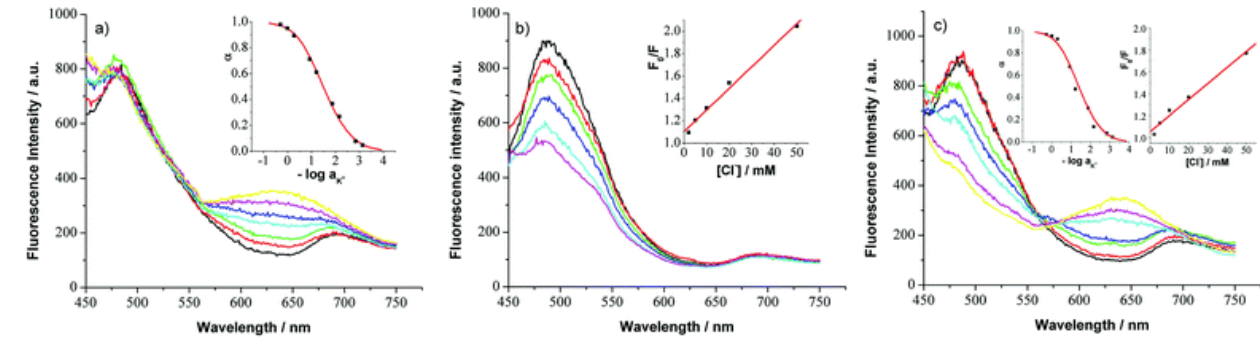
Figure 4. Emission spectra of acrylic/QDs nanospheres acting as: (a) single K + sensors after addition of KHCO solutions. (b) Single Cl - sensors after addition of NaCl solutions. (c) K + /Cl 3 sensors after addition of KCl solutions. Concentrations: 0mM(black), 2 mM(red), 5mM(green), 10mM (blue), 20 mM (cyan), 50 mM (pink) and 200 mM (yellow). Fluorescent signals were recorded = 400 nm) with a spectrofluorimeter (Cary Eclipse, Varian) in a 96-well between 450 and 750 nm ( λ ex microplate. For all samples the pH was fixed at 7.0 by using phosphate buffer. [101] - Reproduced by permission of The Royal Society of